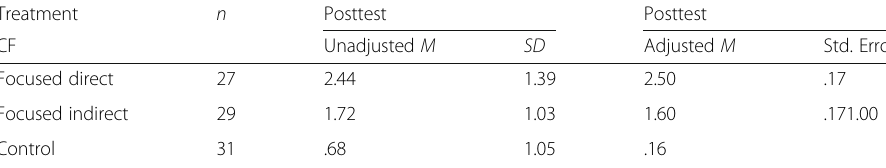
Table 13 Descriptive statistics for the timed grammaticality judgment test Treatment n Posttest Posttest CF Unadjusted M Focused direct Focused indirect